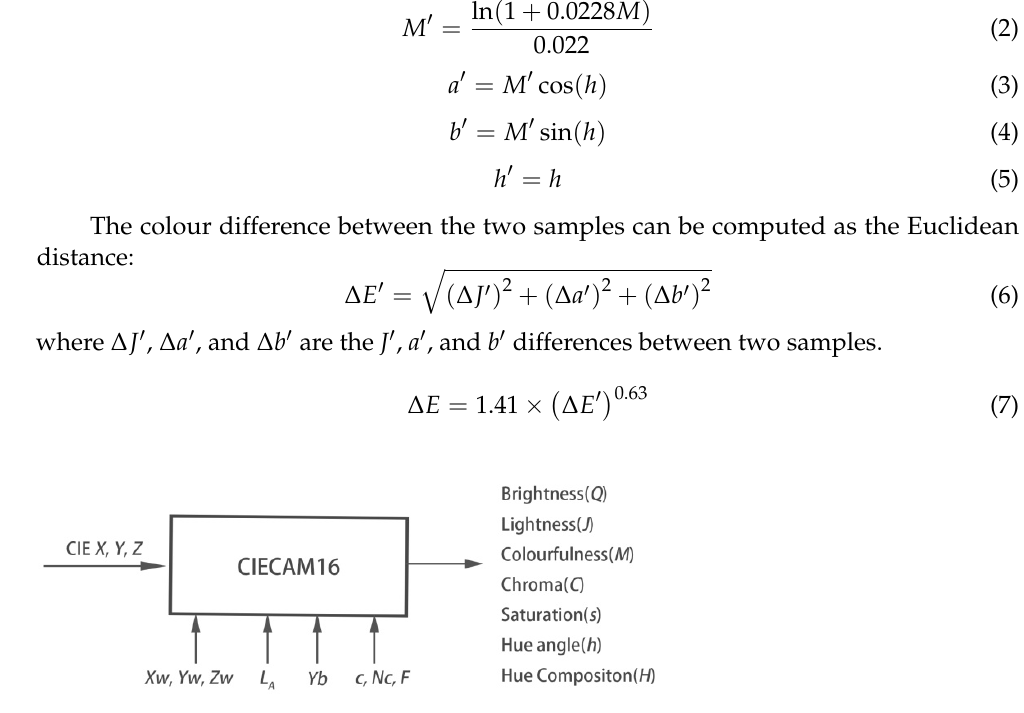
Figure 7. CIECAM16 model input and output parameters.